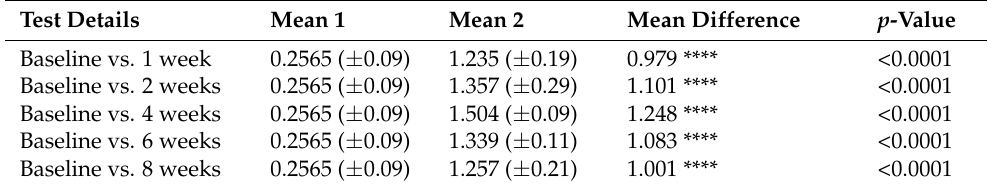
Table 3. Levels of ketone body β -hydroxybutyrate (BHB, mmol/L) of participants ( n = 23) before and after intake of the ketogenic diet.